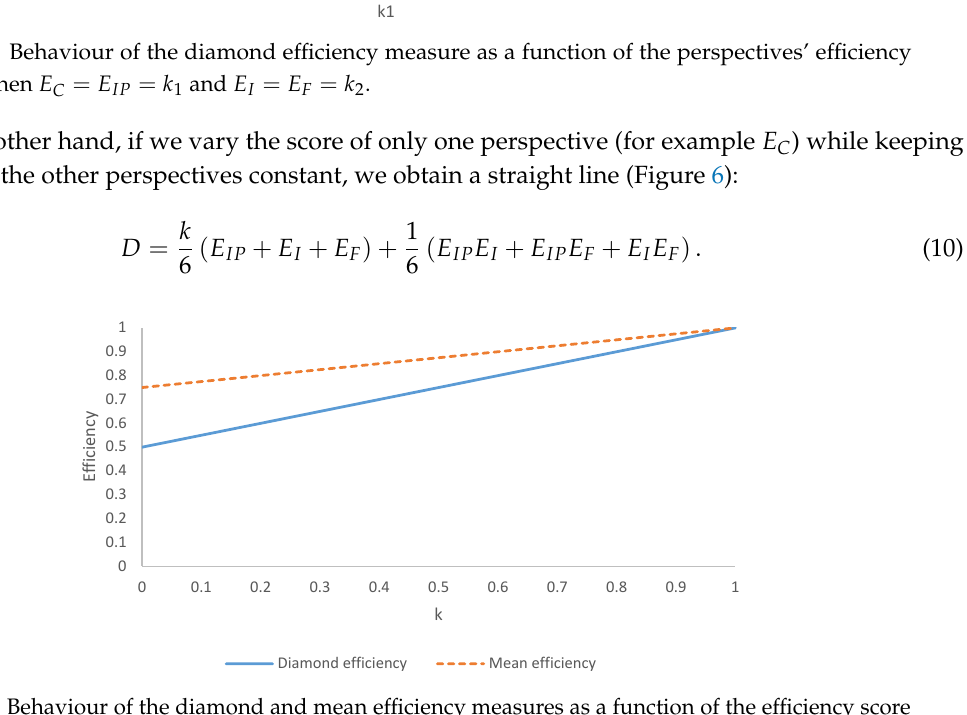
Figure 6. Behaviour of the diamond and mean efficiency measures as a function of the efficiency score of the customer perspective E C = k when E IP = E I = E F =